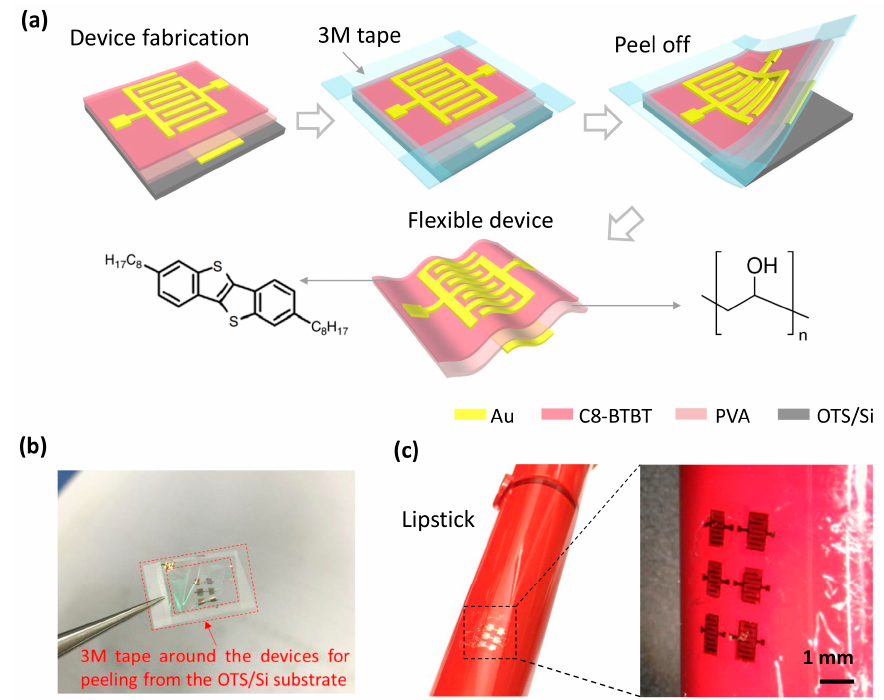
Figure 1. ( a ) Fabrication schematic of an ultrathin C8-BTBT organic thin-film transistor (OTFT) with a bottom-gate top-contact device configuration, and the molecular structures of C8-BTBT and Poly(vinyl alcohol) (PVA). ( b ) Digital photograph of the device. ( c ) Digital photograph of the device adhered on a lipstick tube and 3D optical microscope image of the detail view.